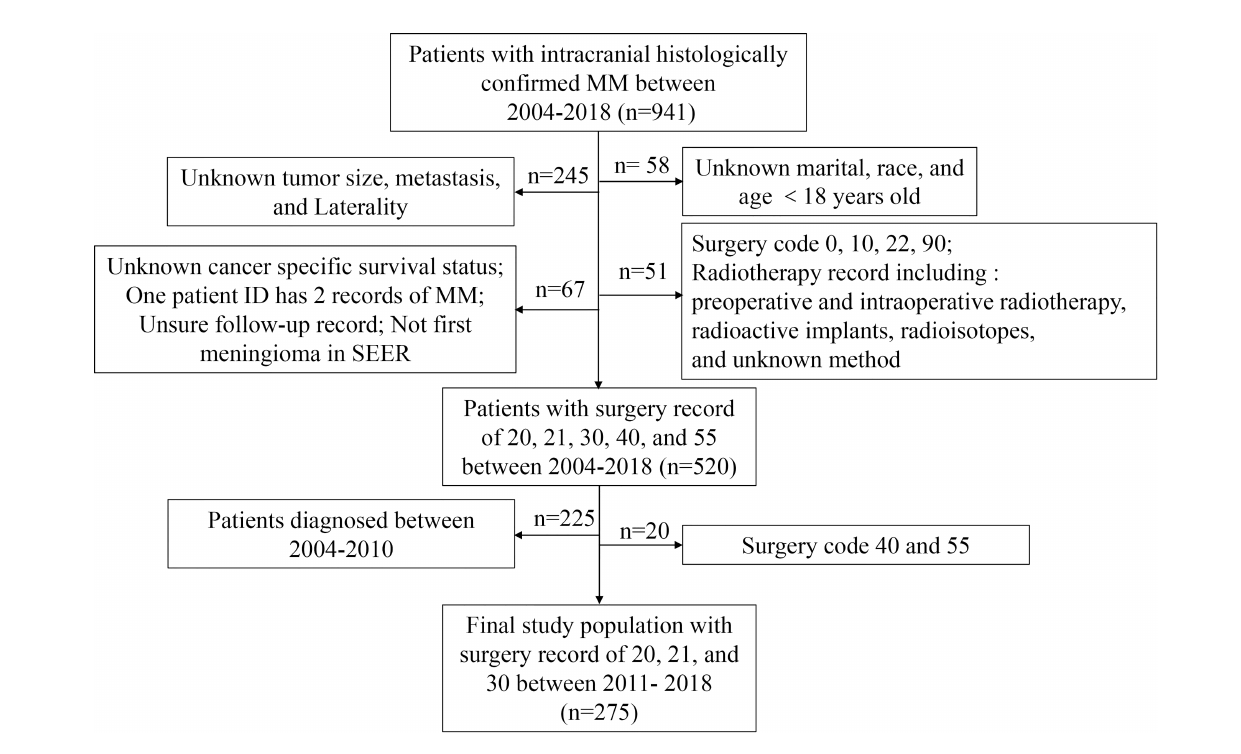
FIGURE 1 | Flow chart of patient selection criteria with de novo MM between 2011 and